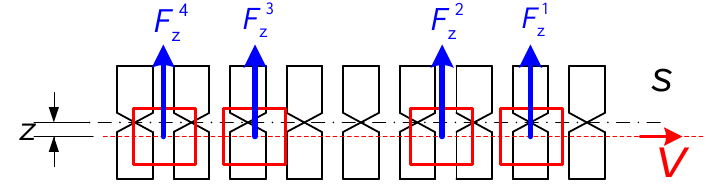
Figure 4. Levitation force on each SCM ( F i